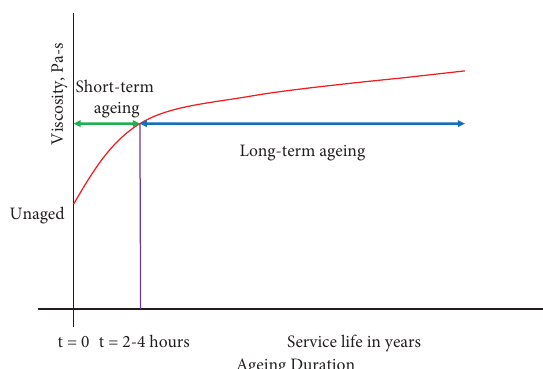
Figure 1: Typical variation in viscosity of bitumen in a bituminous mixture